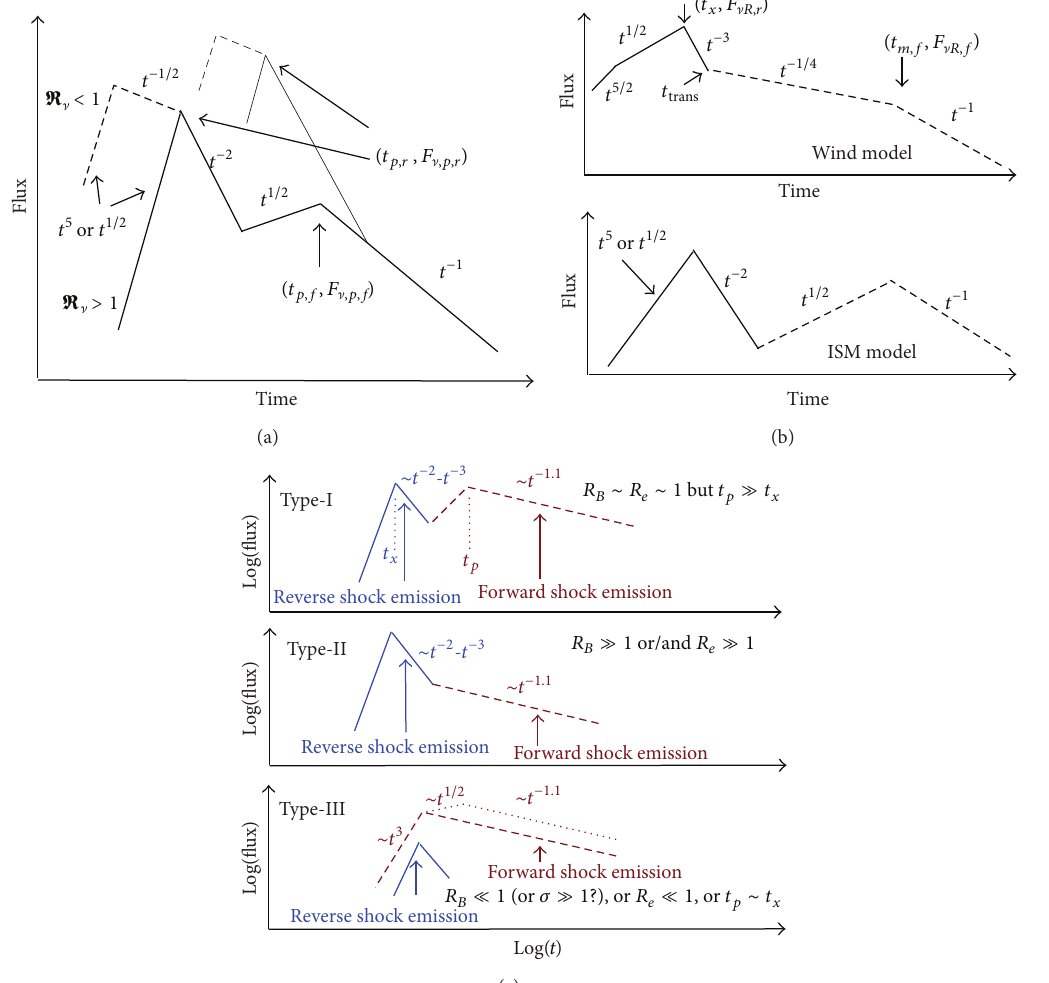
Figure 2: Theoretically expected early optical afterglow lightcurves from reverse plus forward shock emission and illustrative diagram of three classified types: (a) from [58]; (b) from [70]; (c) from